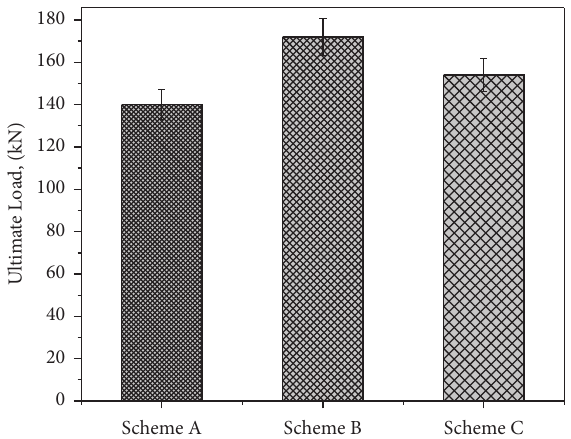
Figure 5: All scheme beams with maximum load carrying capacity.